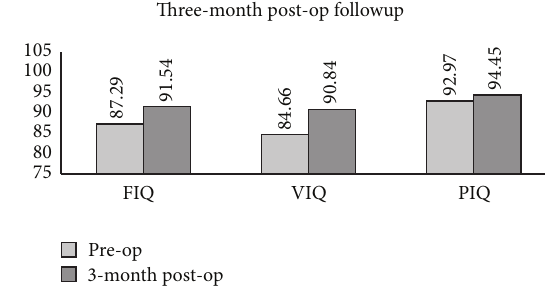
Figure 10: Improved VIQ ( 𝑃 = .001 ) was found in 14 patients three months after